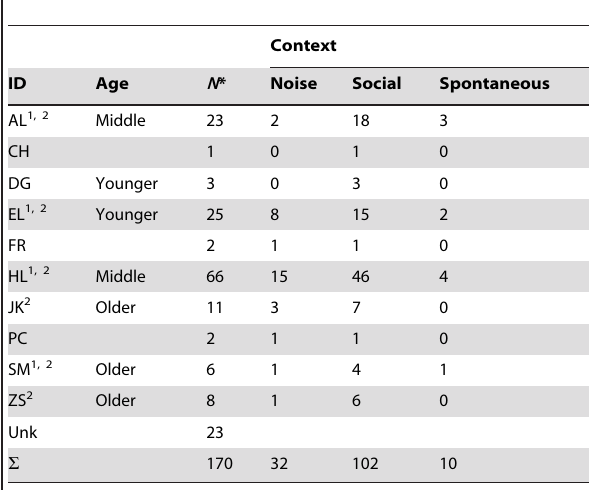
Table 3. Number of calls for each male in each